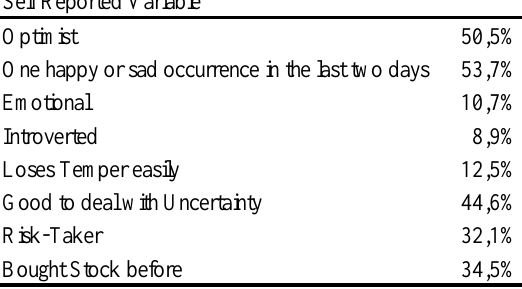
Table 2: Characteristic Information